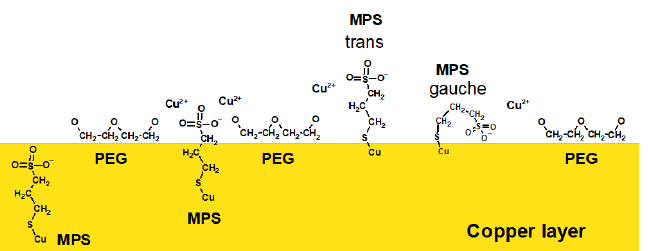
Figure 8. Possible molecular arrangements of MPS and PEG molecules on and into the copper layer during electrodeposition. Please note that some MPS molecules are incorporated into the copper deposit. The chloride adlayer was omitted for clarity.